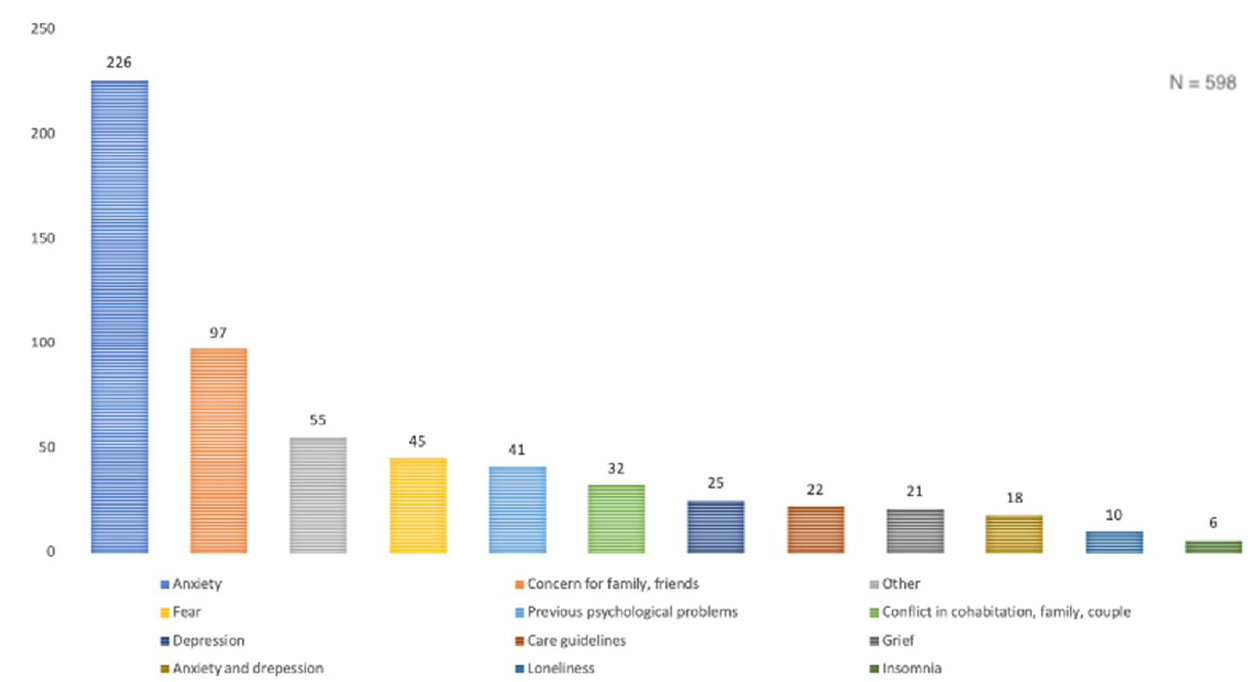
Figure 2. Distribution of the main reasons for calling the COPPA MHCH. Table 1. Reasons for the